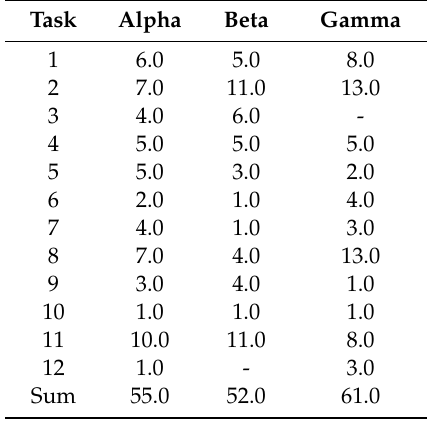
Table 3. Task times for each model t ik (s /